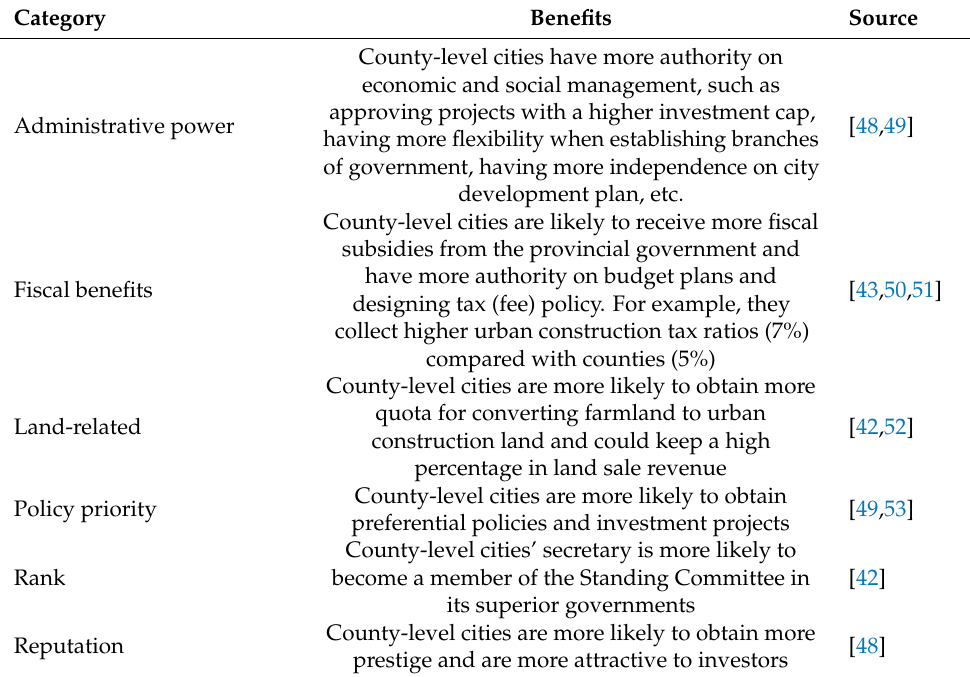
Table 1. The Potential Benefits of Becoming a County-level